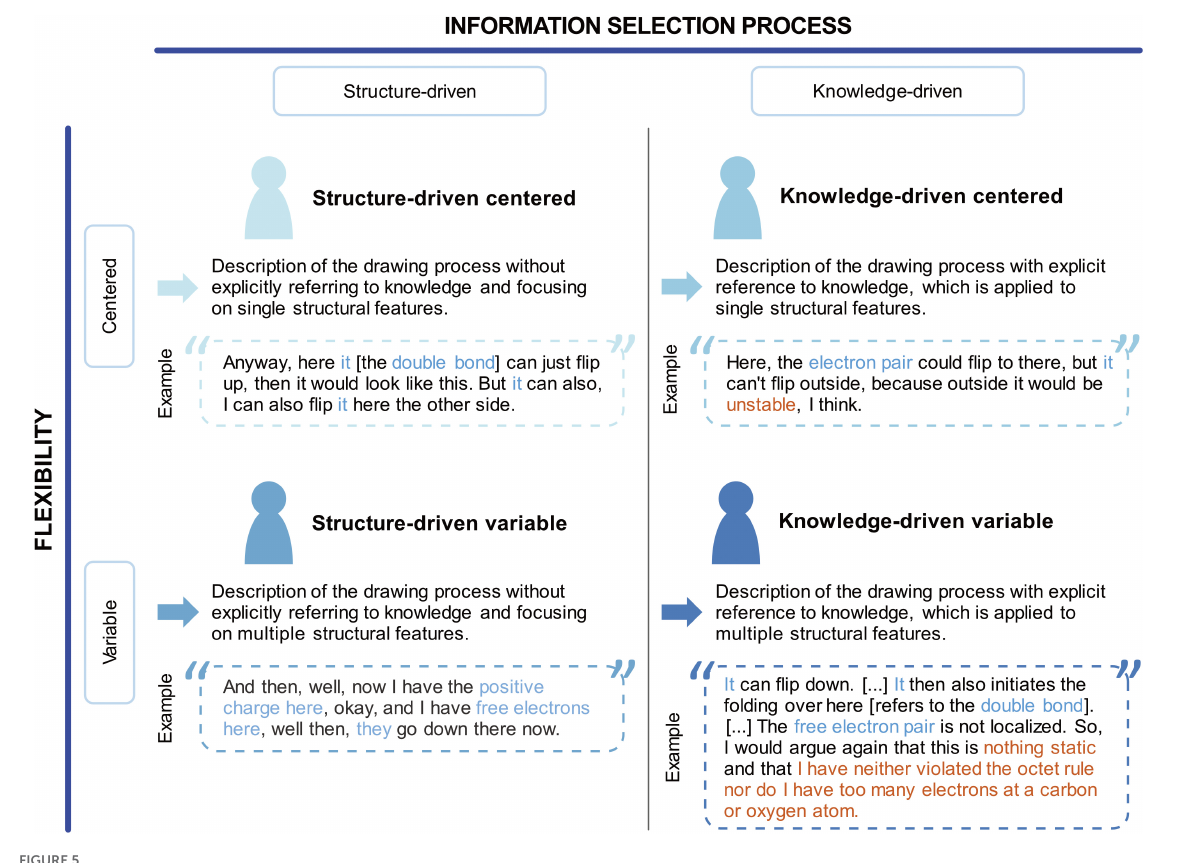
FIGURE5 Coding scheme for students’ visual selection approaches with definitions and student examples. The highlighted blue text in the quotes indicates the structural features the students referred to, while the orange text highlights the verbalized knowledge (e.g., rules and chemical